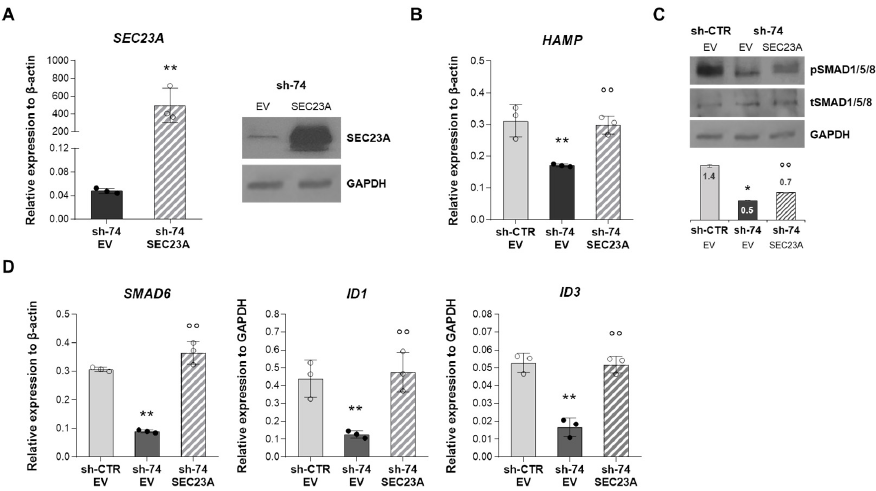
Figure 5. SEC23A overexpression in HuH7 SEC23B -silenced cells . ( A ) Left panel . SEC23A gene expression in sh-74 cells over-expressing empty vector (EV) and SEC23A coding sequence. Data are means ± standard deviation of three independent experiments. (** p < 0.01, sh-74 + EV vs. sh-74 + SEC23A; Student’s t -test). Right panel . Representatives immunoblot of SEC23A protein in total